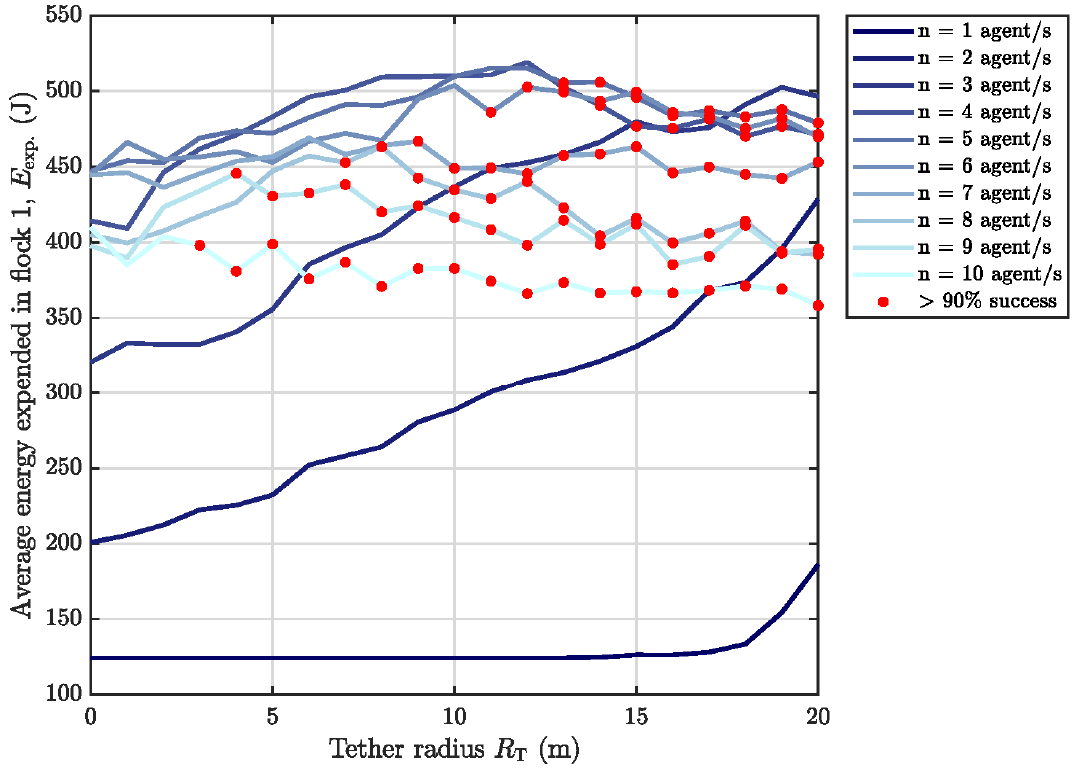
Figure A4. Triple-target scenarios—time performance (darker lines indicate fewer agent numbers while red markers indicate data points whose average success rate is above the given threshold across the 300 independent simulation runs). Maximum agent speed 𝑣 max = 12 m/s.